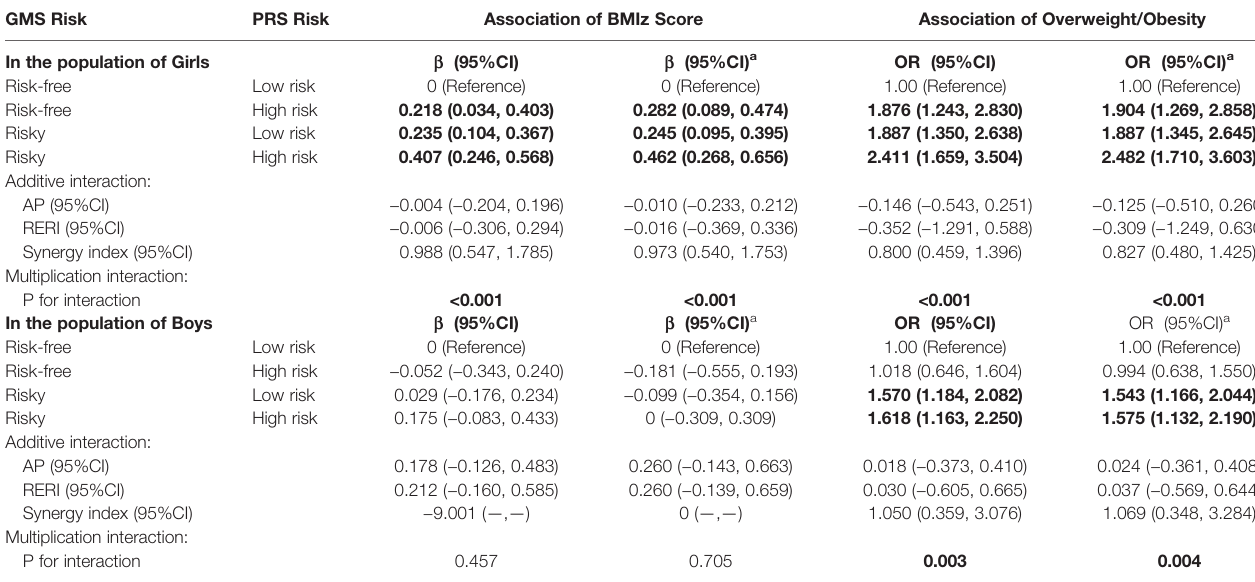
TABLE 3 | Association of the interaction of GMS risk and PRS risk with overweight/obesity using a generalized estimating equation.